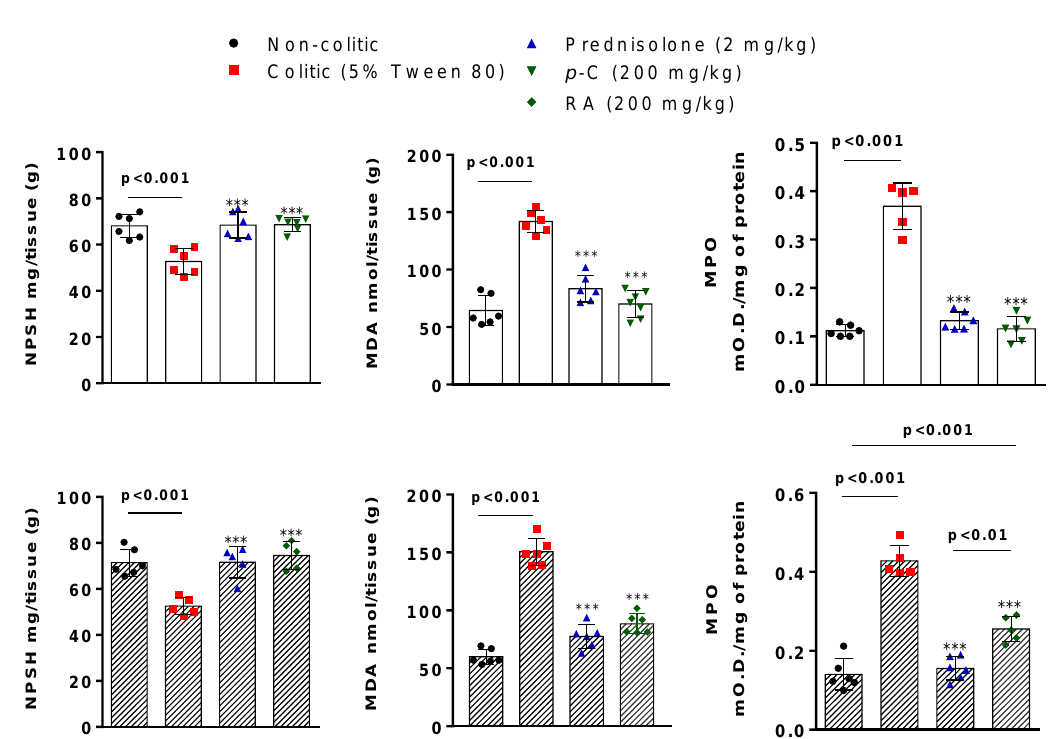
Figure 2. Effect of oral administration of p- C and RA on glutathione (GSH) (non-protein sulfhydryl groups (NPSH)), malondialdehyde (MDA), and myeloperoxidase (MPO) levels in colonic tissue from TNBS-induced ulcerative colitis in rats. Data are expressed as mean ± standard error, having been analyzed by one-way ANOVA followed by Dunnett’s or Tukey’s test. *** p < 0.001, compared to 5% Tween 80 or 0.9% NaCl control groups ( n = 5–6).